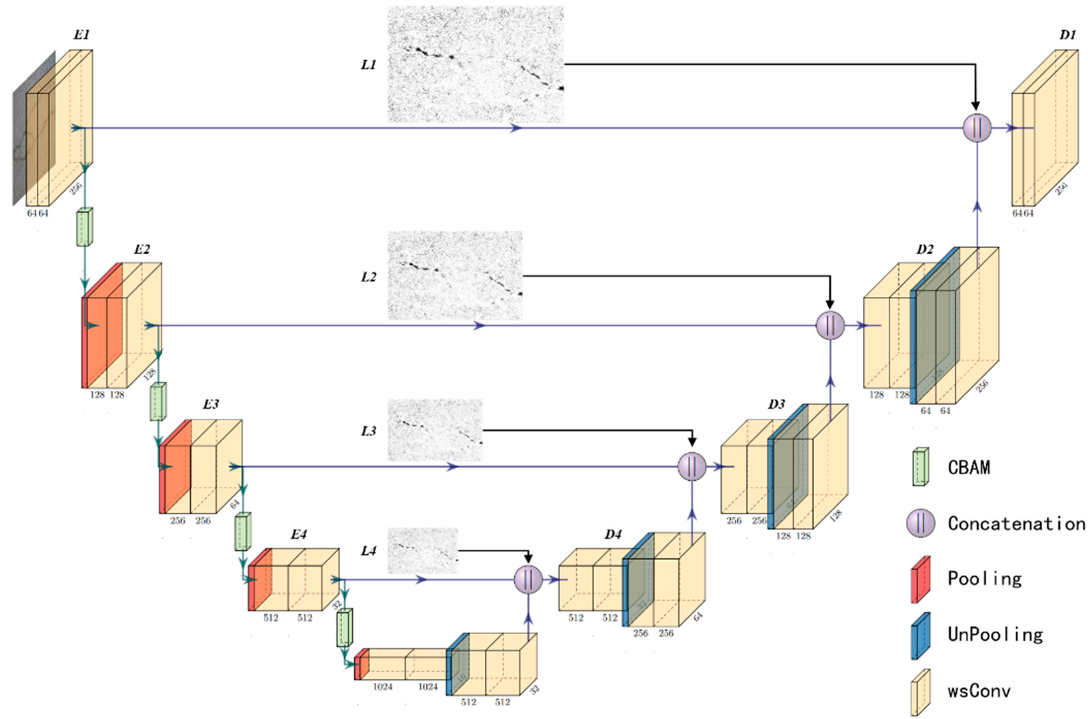
Figure 1. AL-Unet combining CBAM and Laplace